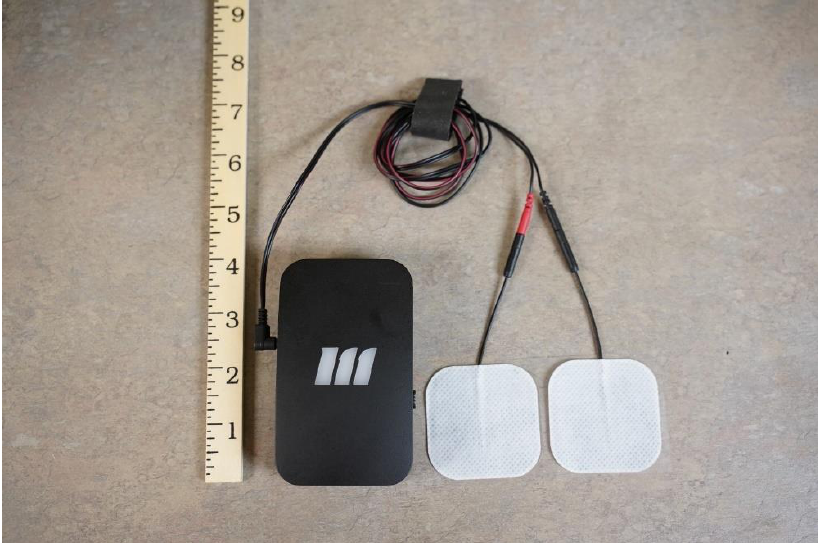
Figure 1. mTrigger device and disposable electrodes. This is a 2-channel system, but in this study, only 1 channel was used.